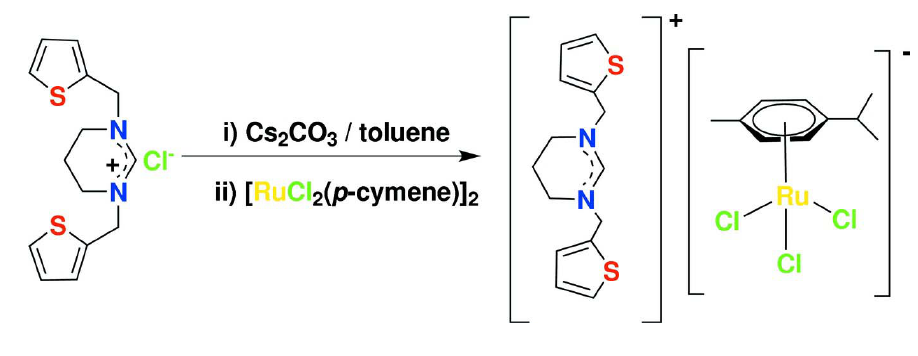
The formetion of the title